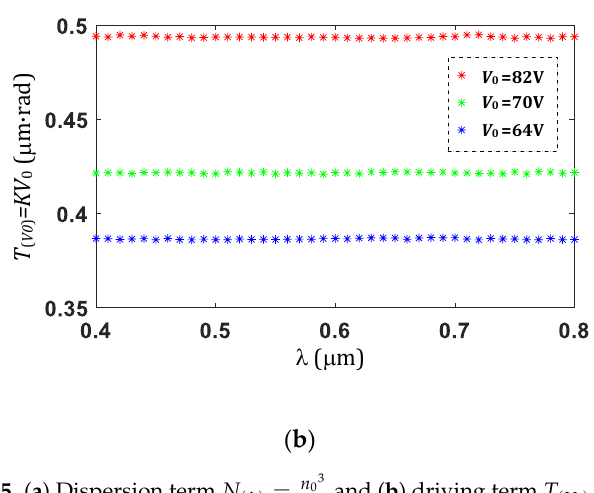
Figure 5. ( a ) Dispersion term N ( λ ) = n 03